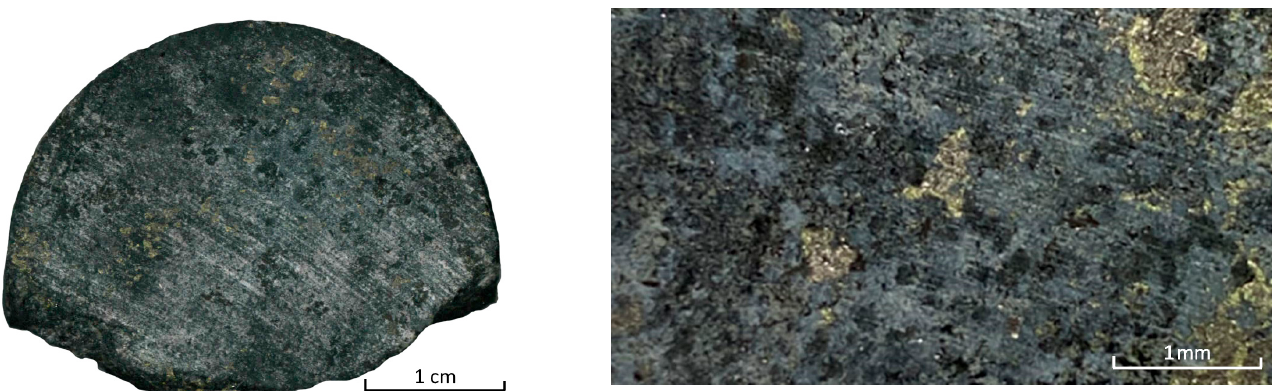
Figure 3. Copper–nickel ore of the Oktyabrskoye deposit.